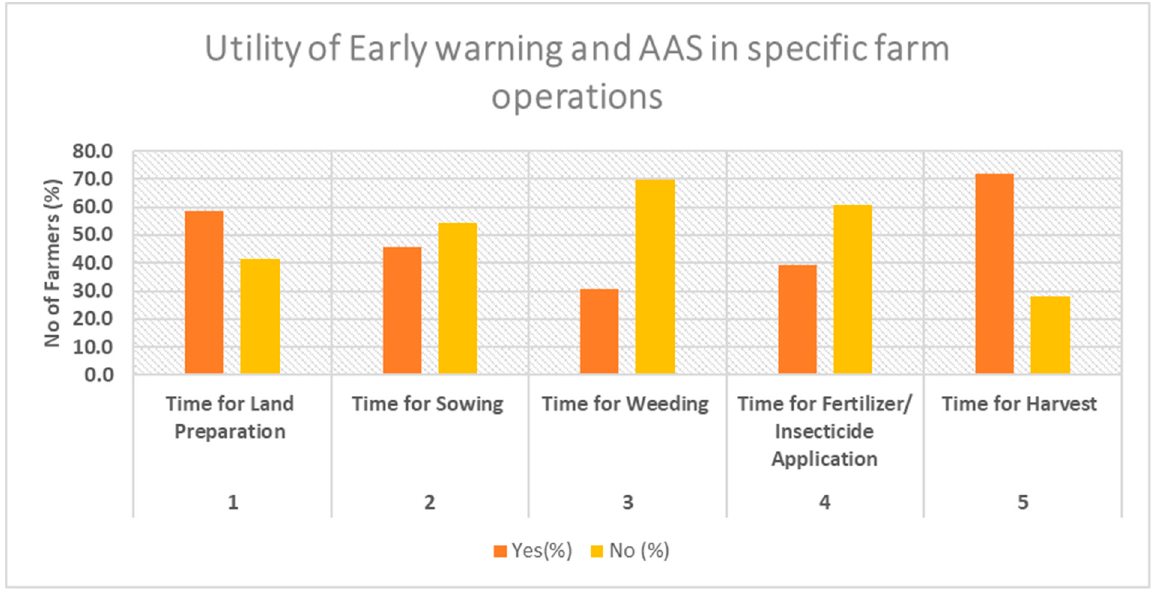
Figure 6. Utility of AAS in specific farm operations (Source: Author formulated from in-depth in- terviews).